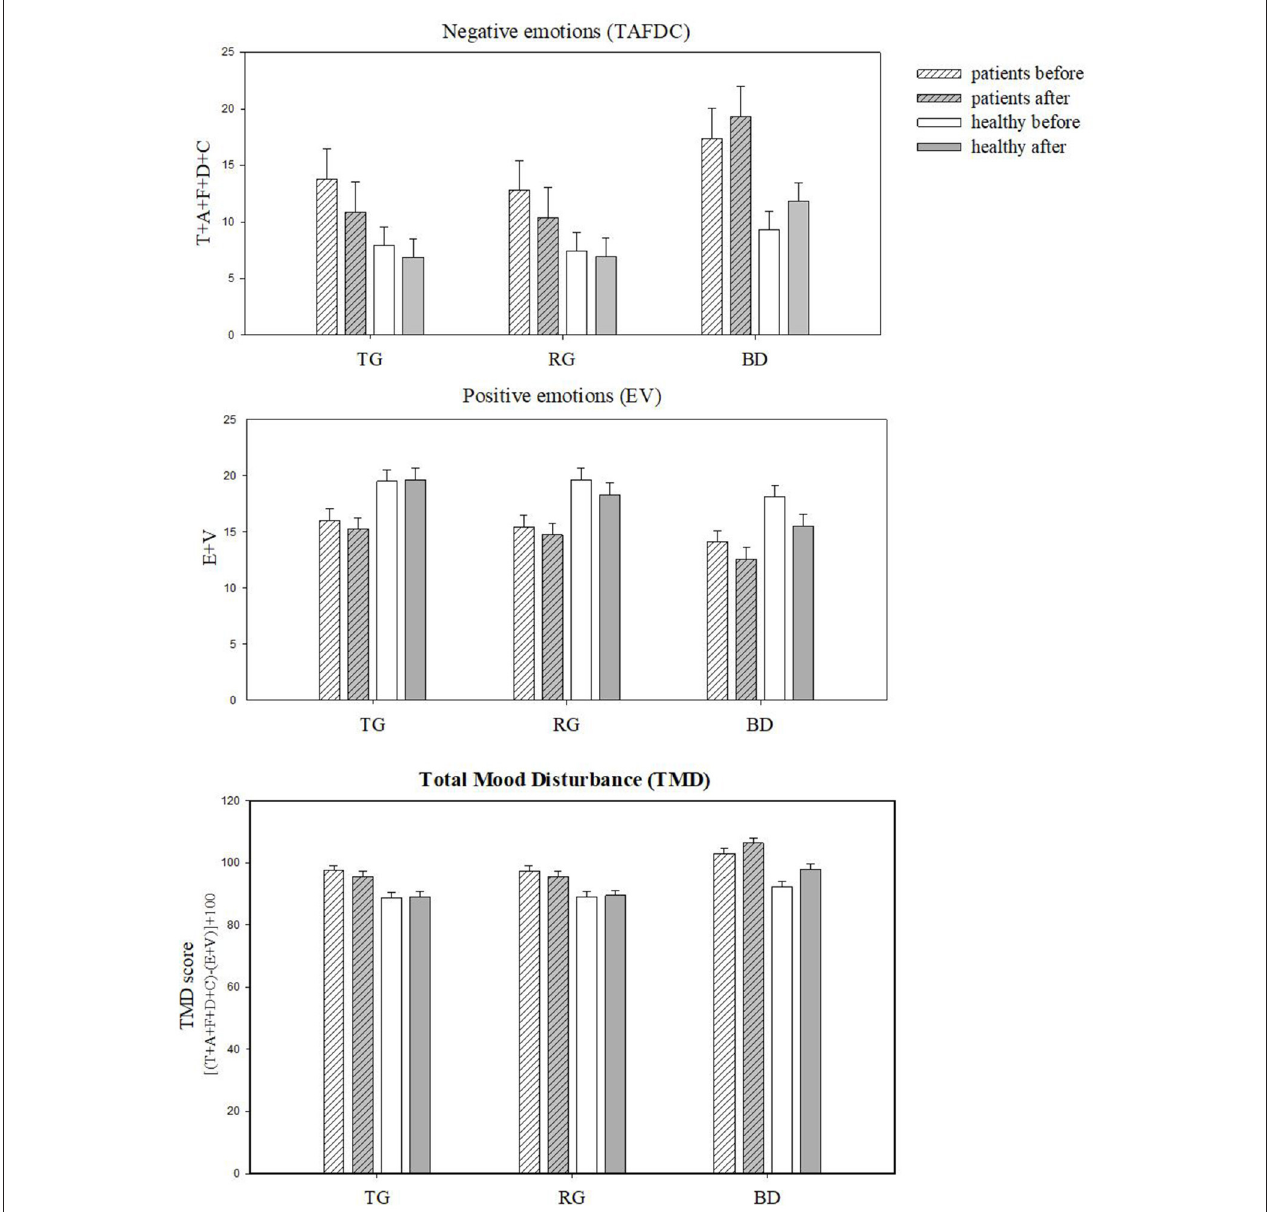
FIGURE 3 | Profile of Mood States scores ( ± SE) grouped by subscales: negative (TAFDC) and positive (EV) and Total Mood Disturbance (TMD) before and after the exposure to three sites: TG, Therapeutic Garden; RG, Residential Green; BD, Busy Downtown.